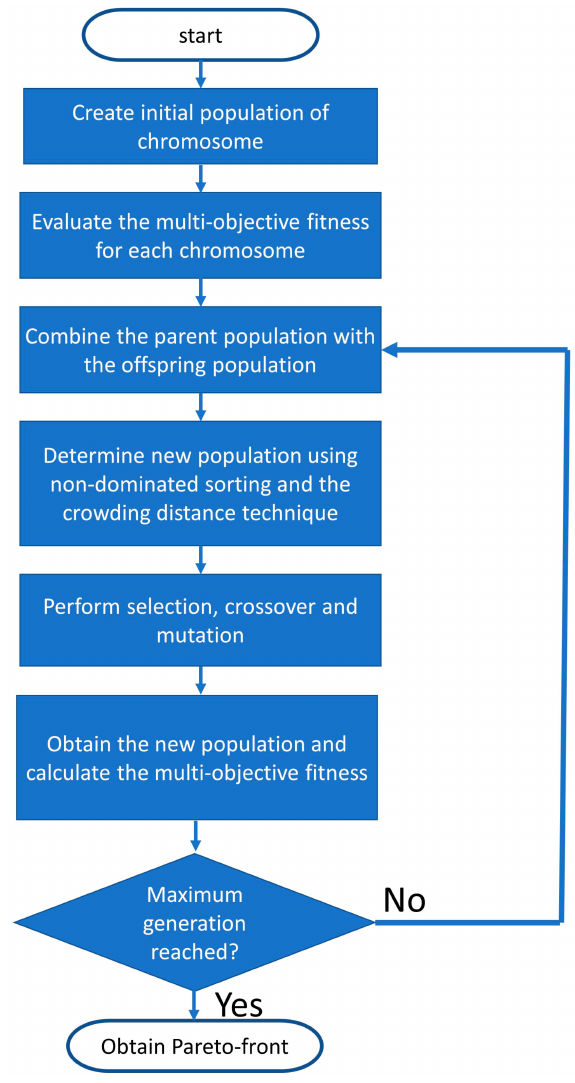
Figure 4. Flowchart of NSGA-II